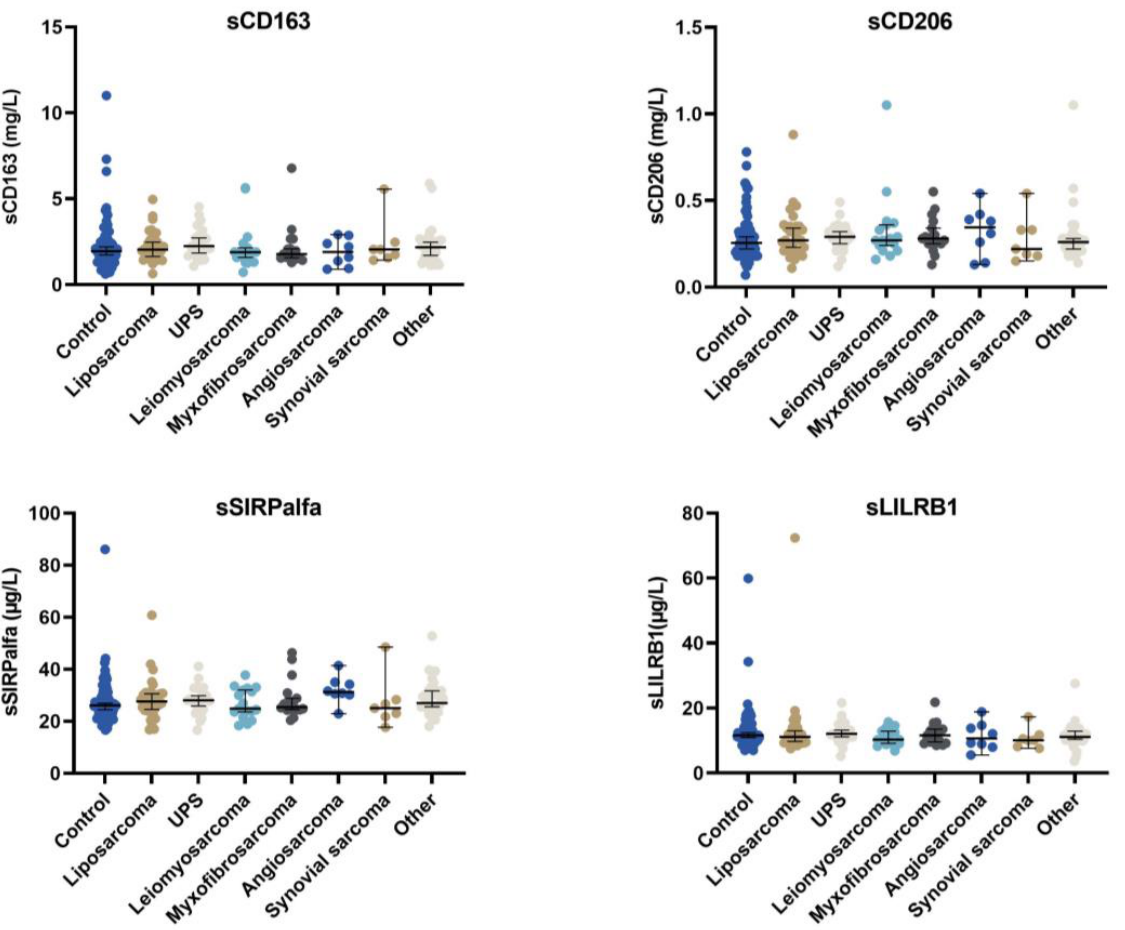
Figure 1. The concentration of the four different macrophage biomarkers according to histological subtype, as well as the control group. Only patients with localised disease at the time of diagnosis were included in the analysis.